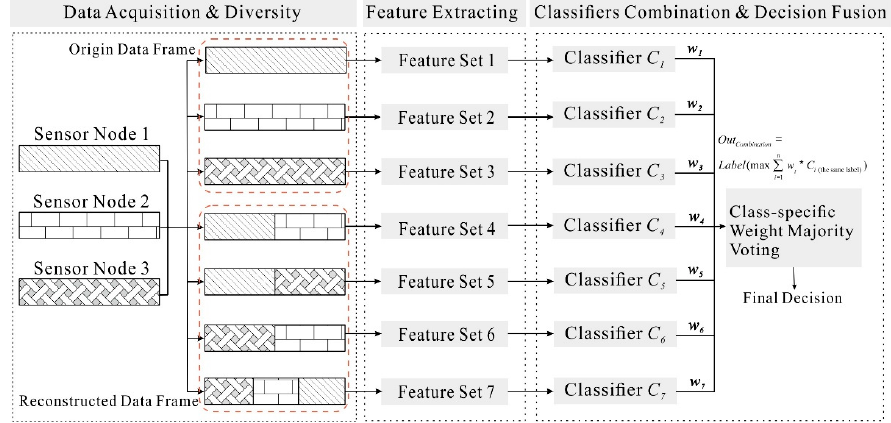
Figure 1. Multi-sensor model combination system architecture block diagram.